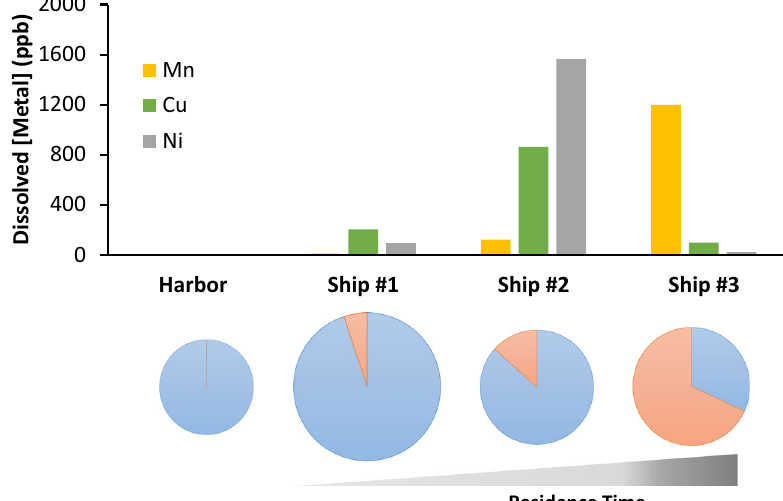
Fig. 5 Graphical comparison of hydrocarbonoclastic community proportions and ballast tank dissolved metal concentrations. Pie chart area is proportional to the total abundance of aerobic and anaerobic hydrocarbon activation genes normalized to rpoB for each library. Blue represents the aerobic, and orange represents anaerobic hydrocarbon activation gene